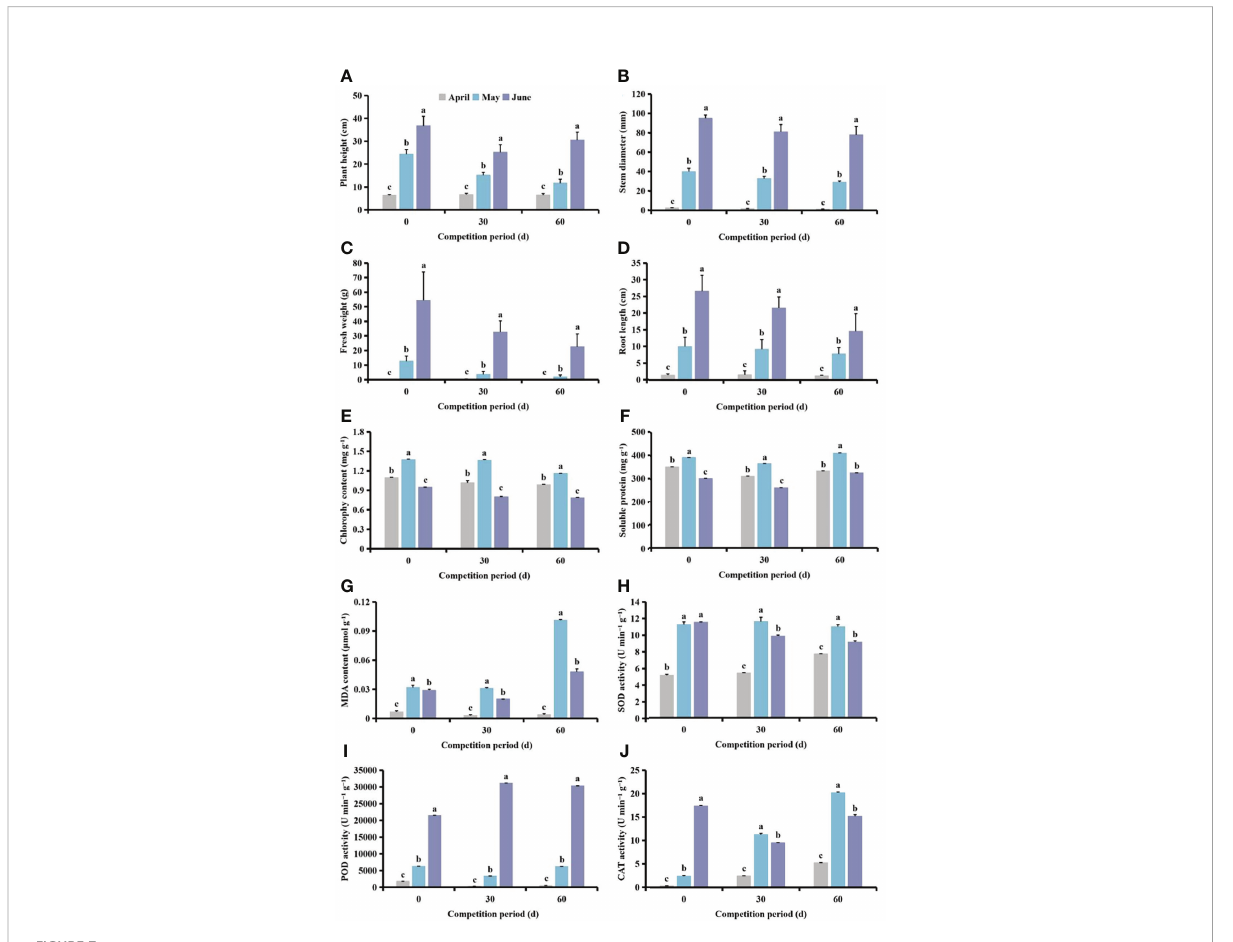
FIGURE 7 Under different competition periods, the (A) plant height, (B) stem diameter, (C) fresh weight, (D) root length, (E) chlorophyll, (F) soluble protein and (G) malondialdehyde (MDA) content, and (H) superoxide dismutase (SOD) (I) peroxidase (POD) and (J) catalase (CAT) activities in cotton at different Scirpus planiculmis planting time. The mean value ± standard data were presented in the fi gure. Different alphabetical letters indicate the signi fi cant differences between different different Scirpus planiculmis planting time ( p